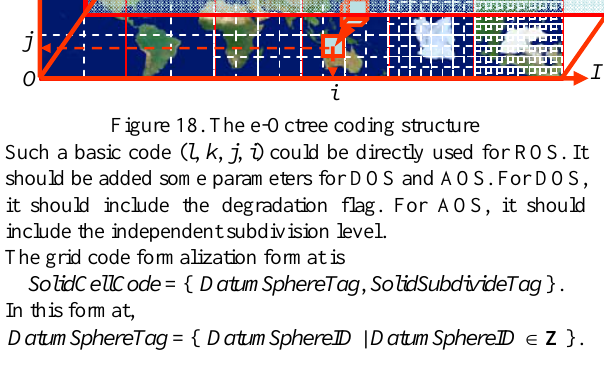
Figure 13. ROS near north polar